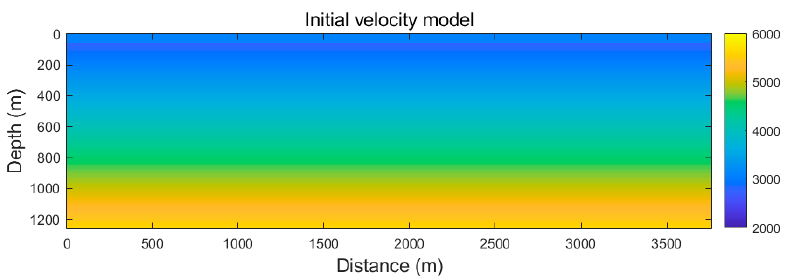
Figure 5. The initial velocity model for FWI. Table 3. Numerical tests for the multisource FWI method. Table 3. Numerical tests for the multisource FWI